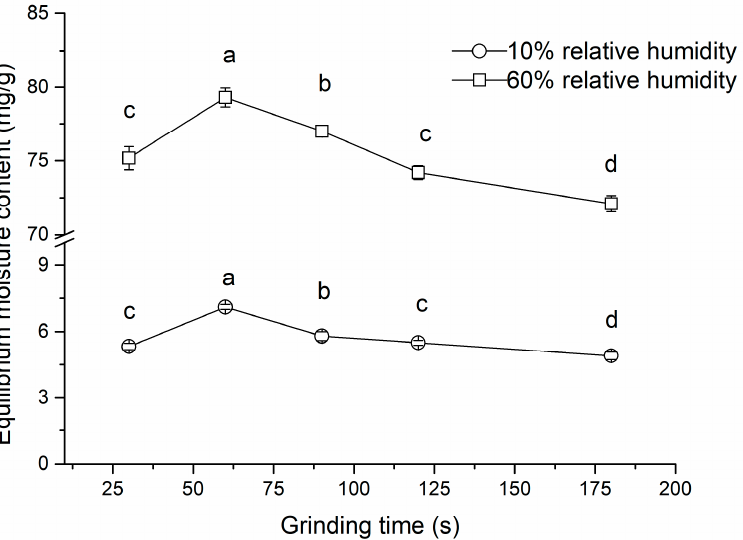
Figure 1. The effect of grinding time on the equilibrium moisture content of carob powder at two relative humidity (RH) levels. Mean ± standard deviation ( N = 2). Different small letters indicate significant differences ( p < 0.05) within the RH level.